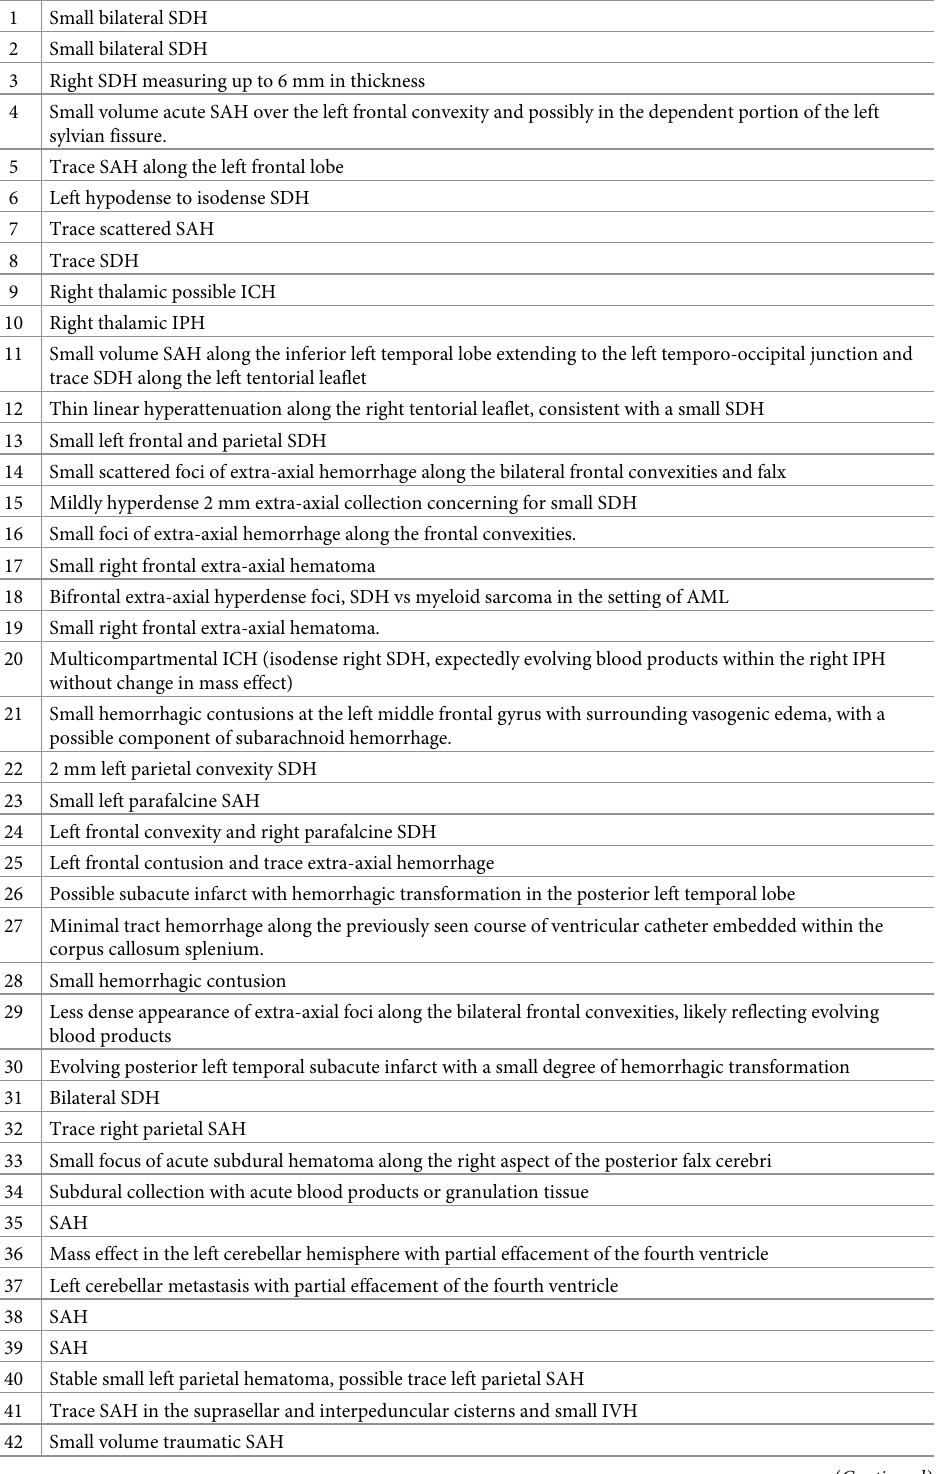
Table 4. False negative IC- cases. Case